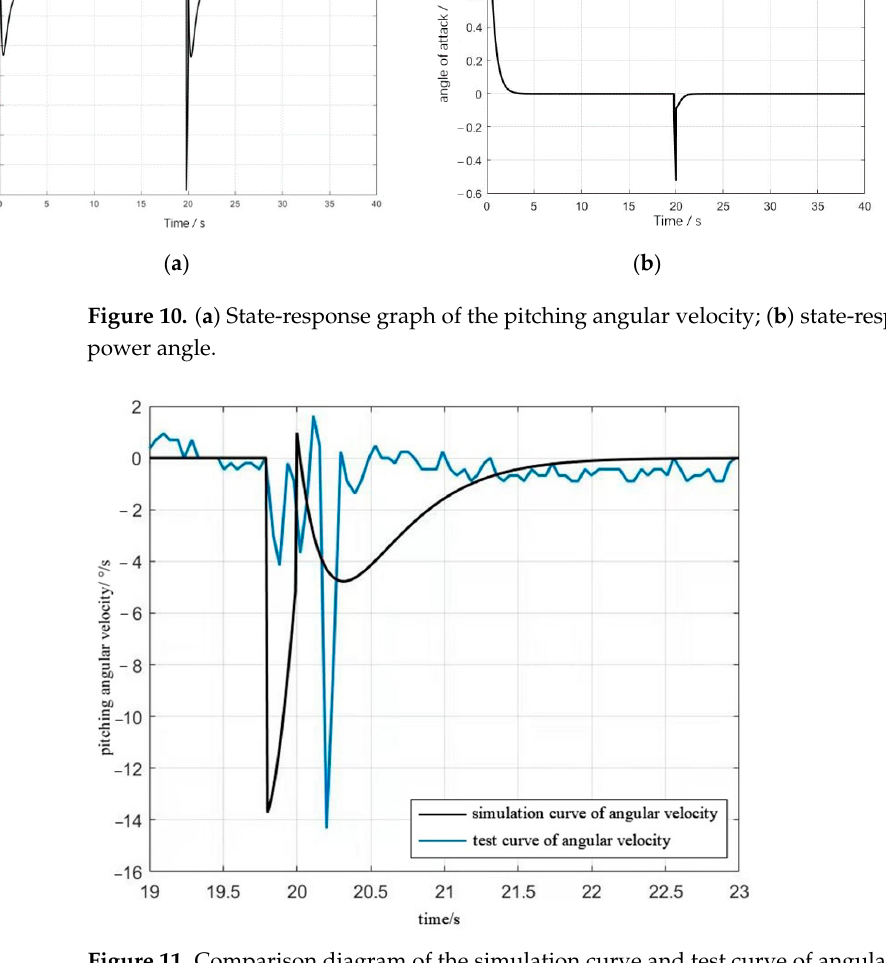
Figure 11. Comparison diagram of the simulation curve and test curve of angular velocity.